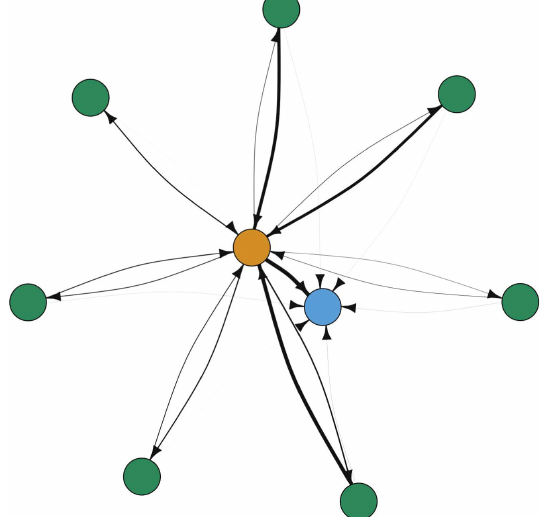
FIG. 1. Sample network diagram. The central, orange node corresponds to the instructor, the green nodes correspond to a student group, and the blue node corresponds to the whole class (so that edges between an orange or green node and the blue node represent presentations to the whole class). The edges connecting the nodes are weighted to represent the duration of the inter- actions and directional to indicate who initiated the interaction.